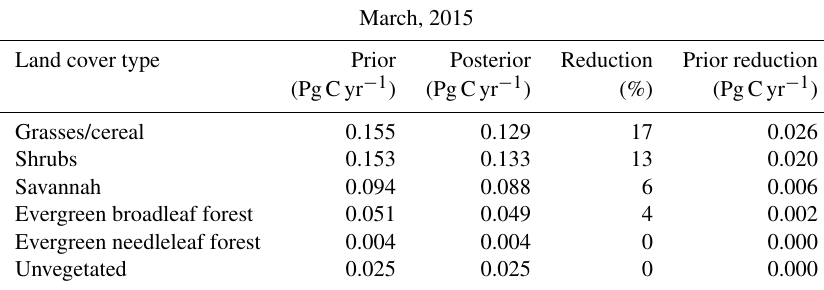
Table D3. Sensitivity case (3): uncertainty reduction of total CO 2 Australian flux (in PgCyr − 1 ) classified by MODIS ecotype (March,